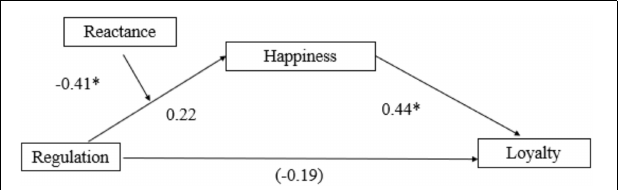
FIGURE 3 | Interpersonal emotion regulation increases loyalty through changing emotional responses toward the service interaction in Study 4. This relationship is moderated by reactance toward regulation ∗ p < 0.05 ( Value in parentheses indicates the effect of emotion regulation on the dependent variable after controlling for the